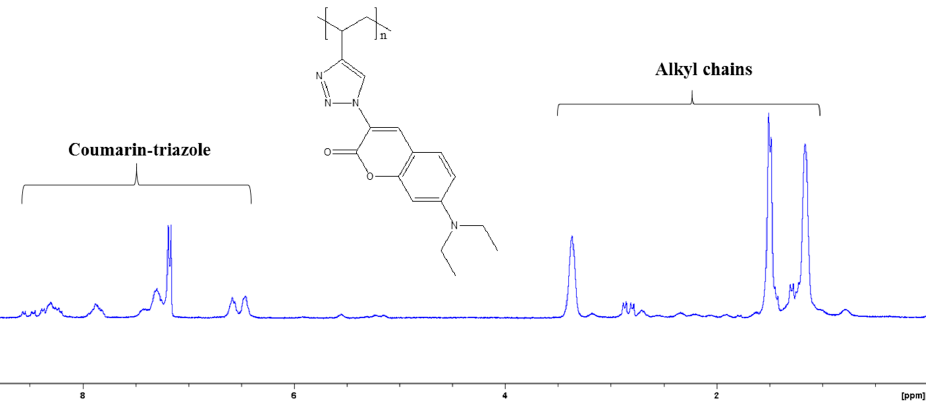
Figure 1 . 1 H NMR spectrum for P1 in CDCl 3 .